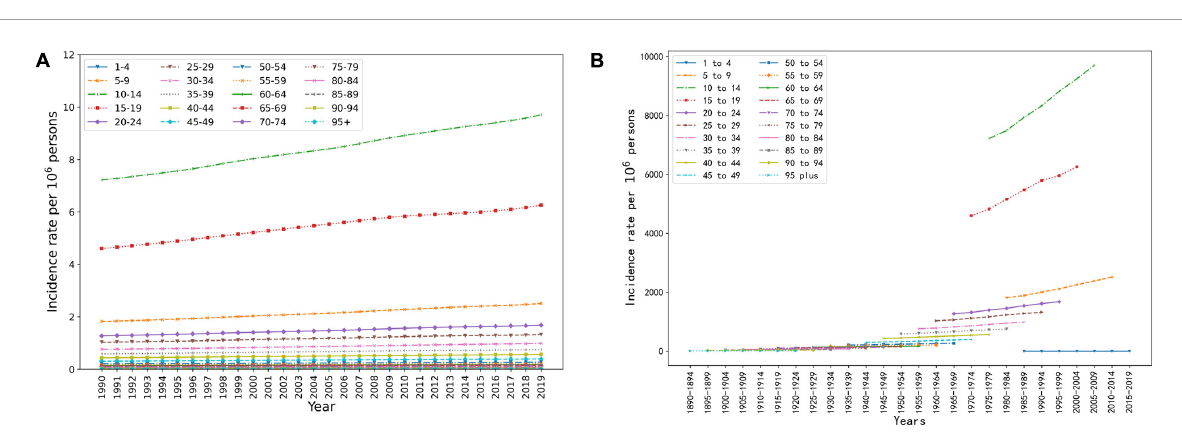
FIGURE3 Age, period, and birth cohort trends of acne vulgaris in China. (A) The period trend of acne incidence rate in different age groups in China. (B) The birth cohort trend of acne incidence rate in different age groups in China.